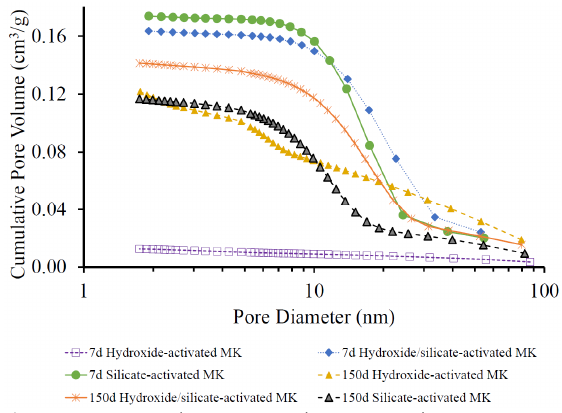
Figure 5. Nitrogen adsorption cumulative pore volume curves as a function of average pore diameter for hydroxide ‐ , hydroxide/silicate ‐ , and silicate ‐ activated metakaolin (MK) at 7 and 150 days.